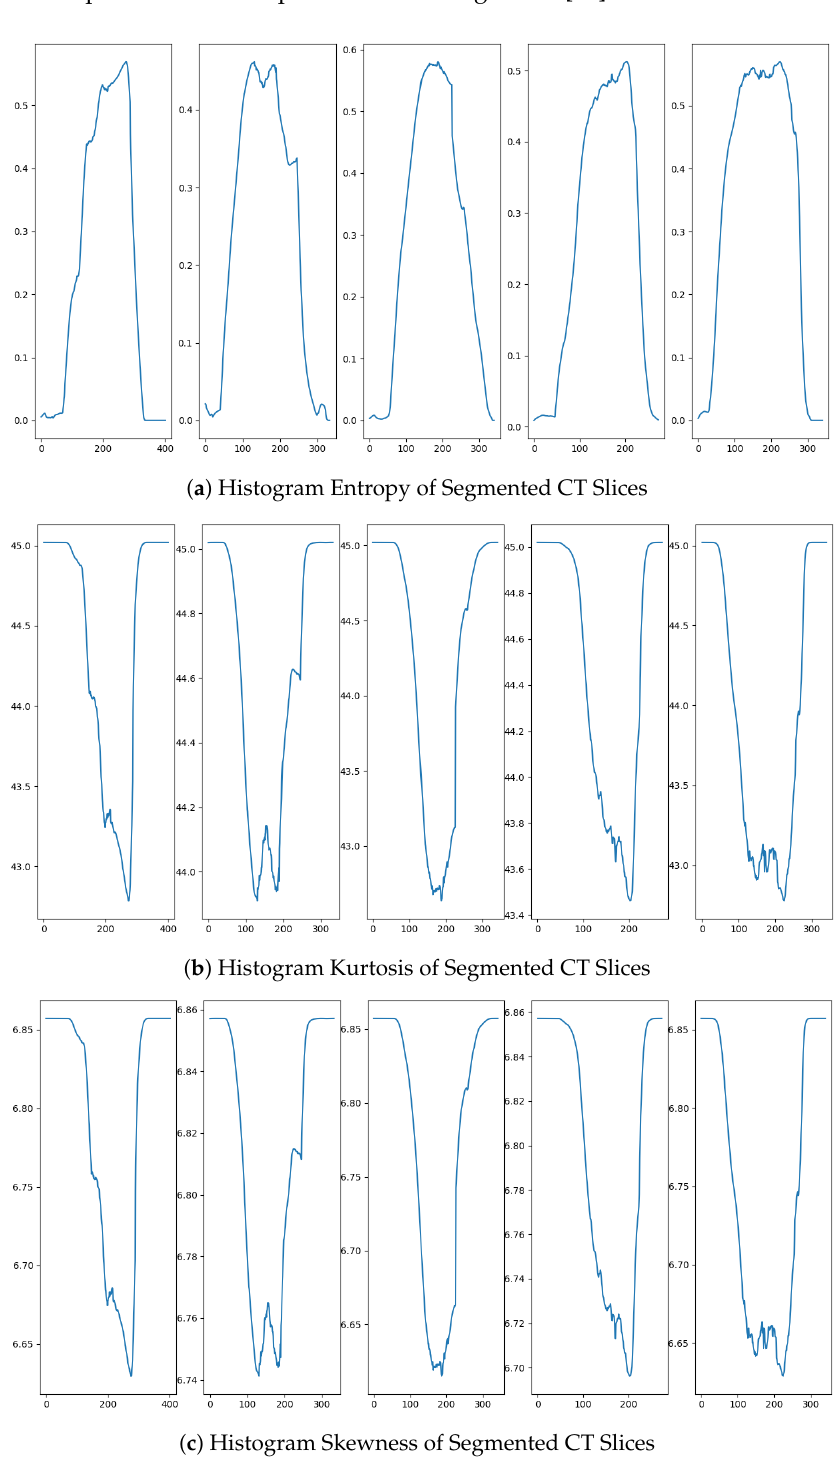
Figure 8. Histogram-based Features extracted from Lung tissue binary mask